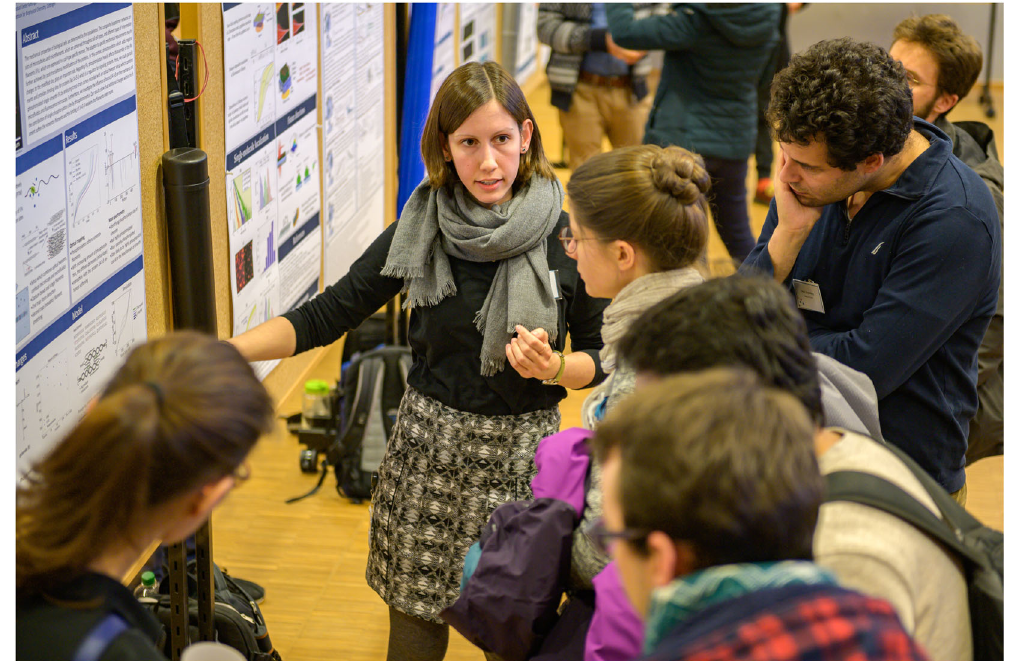
Fig. 1 Poster session. Ph.D. students from the International Max Planck Research School for the Physics of Biological and Complex Systems, and other institutions, presented and discussed their work with their peers, and with more experienced researchers, over two split sessions due to the amount of contributions received. Photo from Irene Böttcher-Gajewski; Public Relations Of fi ce and MediaService at the Max Planck Institute for Biophysical Chemistry.